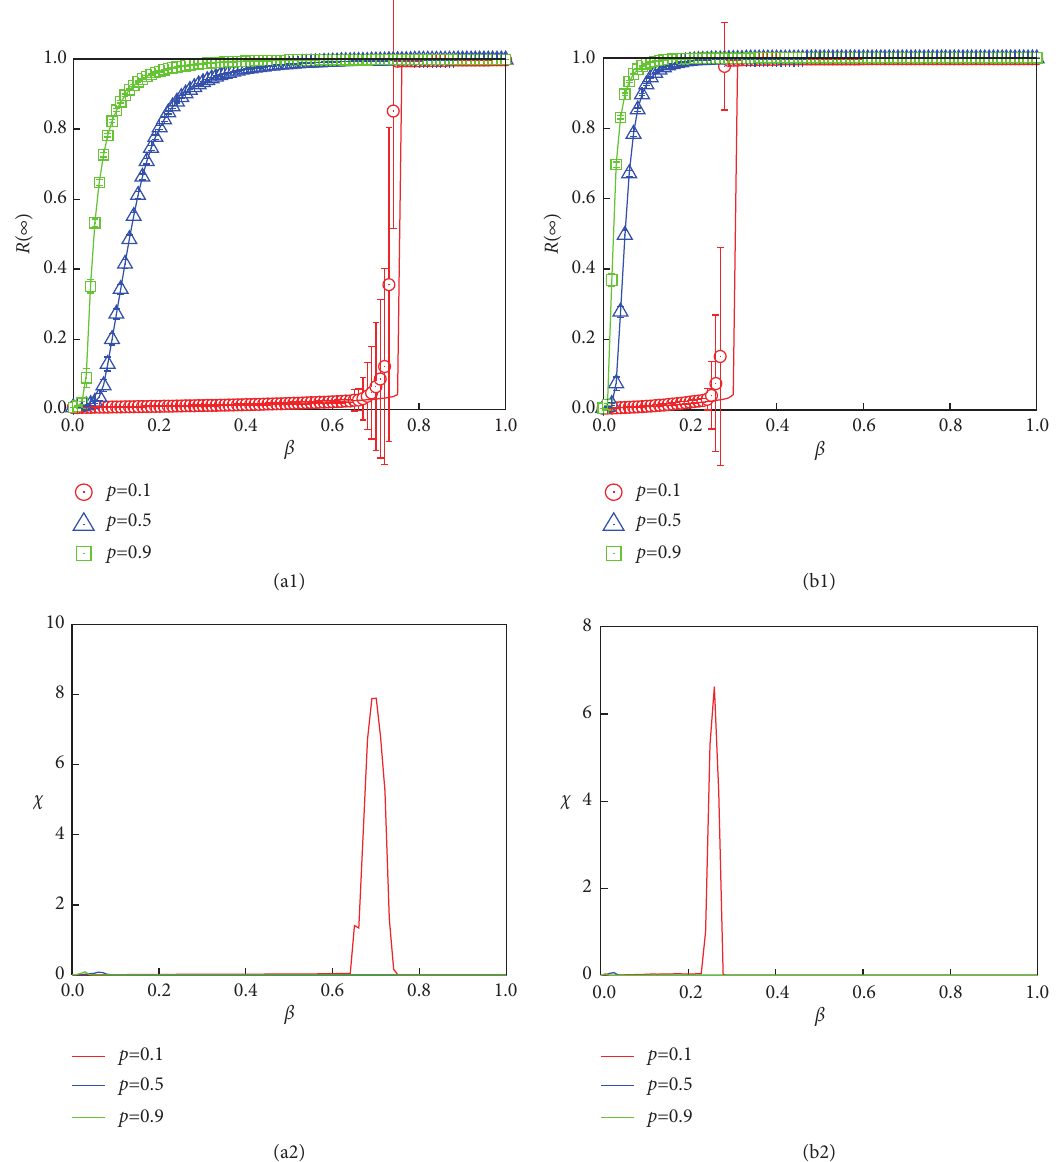
Figure 2: The effects of unit propagation probability β on the final adaption size with various proportions of fashionable nodes p on � 2 ) and (b1) ( α � 3 ) show the influence of weight distribution heterogeneity over phase transition. weighted ER network. (a1) ( α ω ω Subgraphs (a2) and (b2) represent the relative variances of the theoretical analyses and the critical points of (a1) and (b1), respectively. In addition, in subgraphs (a1) and (b1), the theoretically predicted values (dotted lines) coincide well with the simulation values (symbols). � 0 . 005, T � 1, and T � Other parameters are ρ p q 0